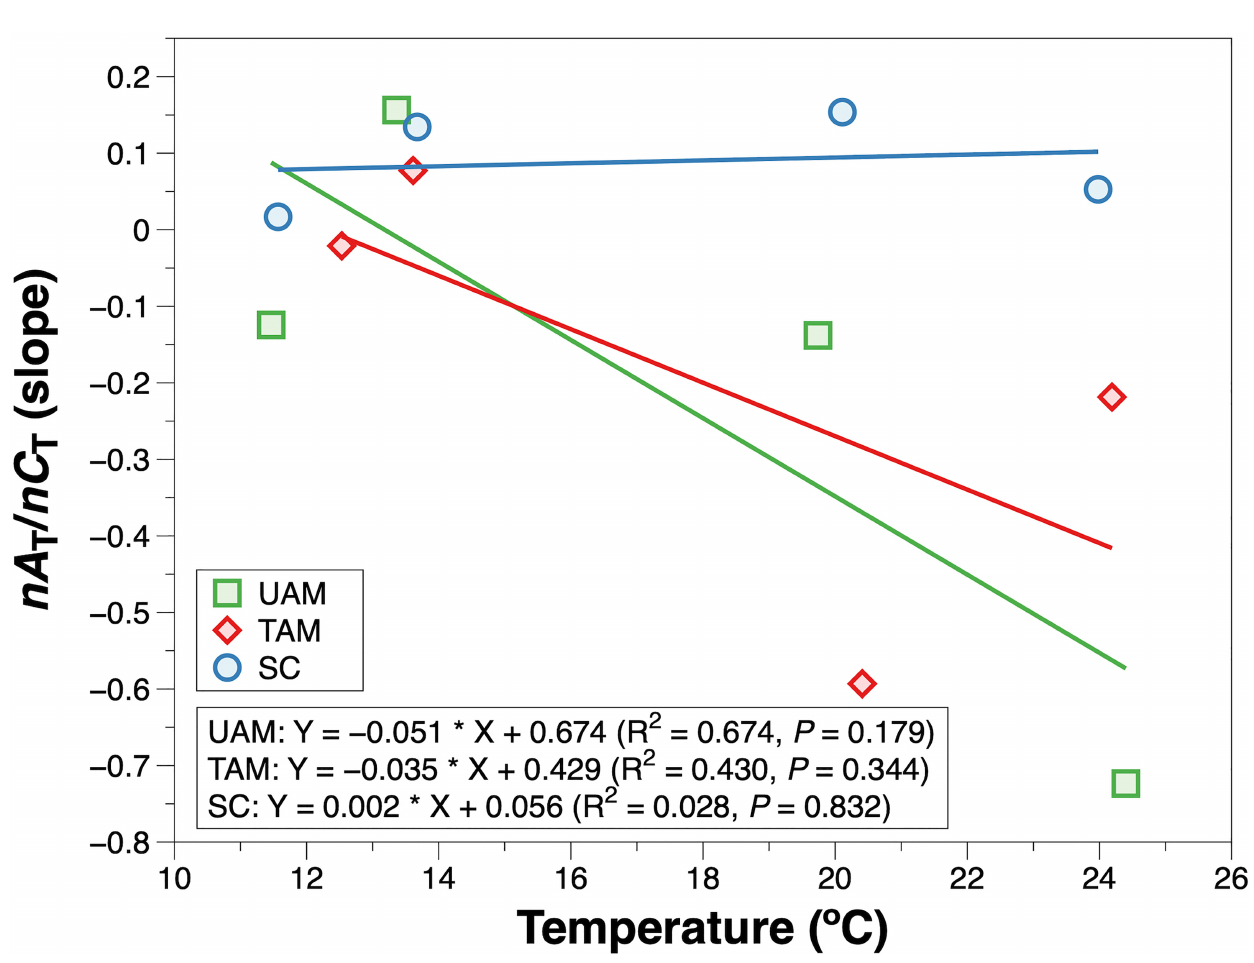
FIGURE 4 | The slope of salinity normalized total alkalinity ( nA T ) and salinity normalized total inorganic carbon ( nC T ) in response to temperature. The solid line is the least square fi tting curve of data using the linear regression model. Values for different macroalgal habitats: ulvoid algal mat (UAM, green square); turf algal mat (TAM, red diamond); coexisting Sargassum horneri and crustose coralline algae (SC, blue